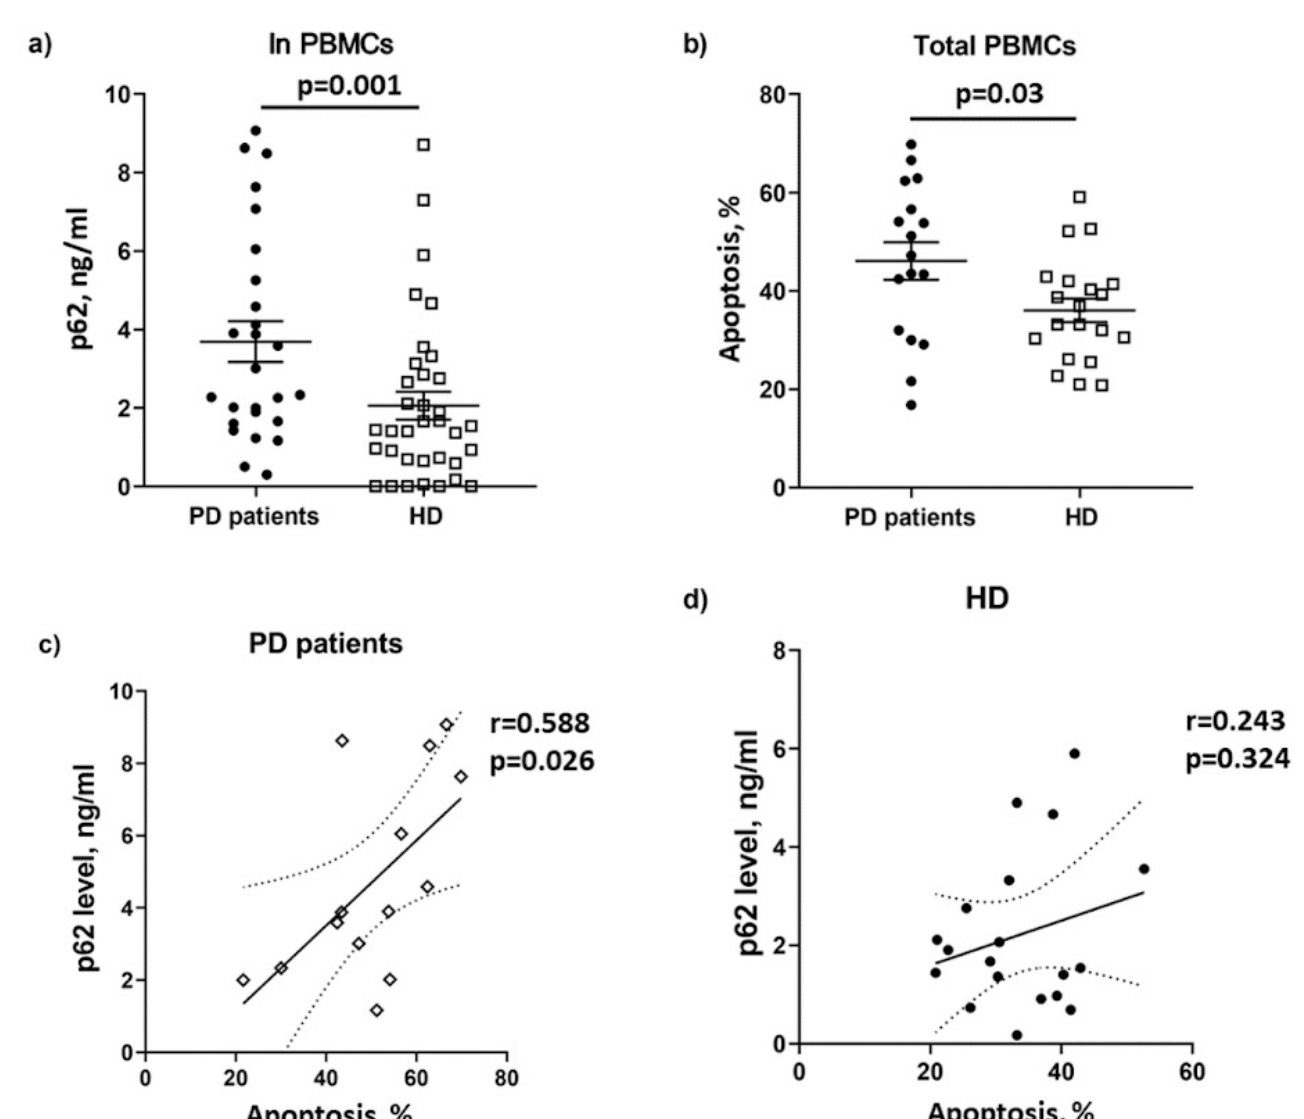
Figure 3. The intracellular level of p62 protein and the percentage of spontaneous apoptosis in PBMC of PD patients and HDs and their correlation. ( a ) Differences in the intracellular level of p62 protein (ng/mL) between PD patients and the HD group. ( b ) The percentages of cells undergoing spontaneous apoptosis among PBMC from PD patients and HD. ( c ) Correlation analysis between apoptotic cell percentage and p62 level (ng/mL) in PBMC from PD patients ( d ) from HDs. Solid lines, mean ± SEM. Pearson’s correlation coefficient was used; dotted line, 95% confidence interval.